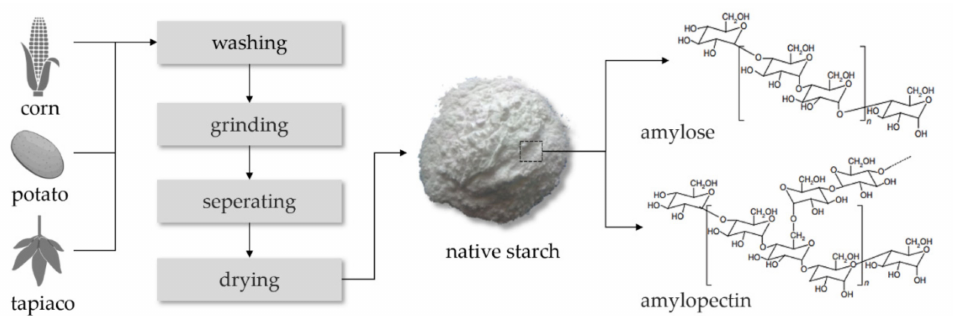
Figure 1. The process of destructured native starch from bio-based resources and the structure of starch with amylose and